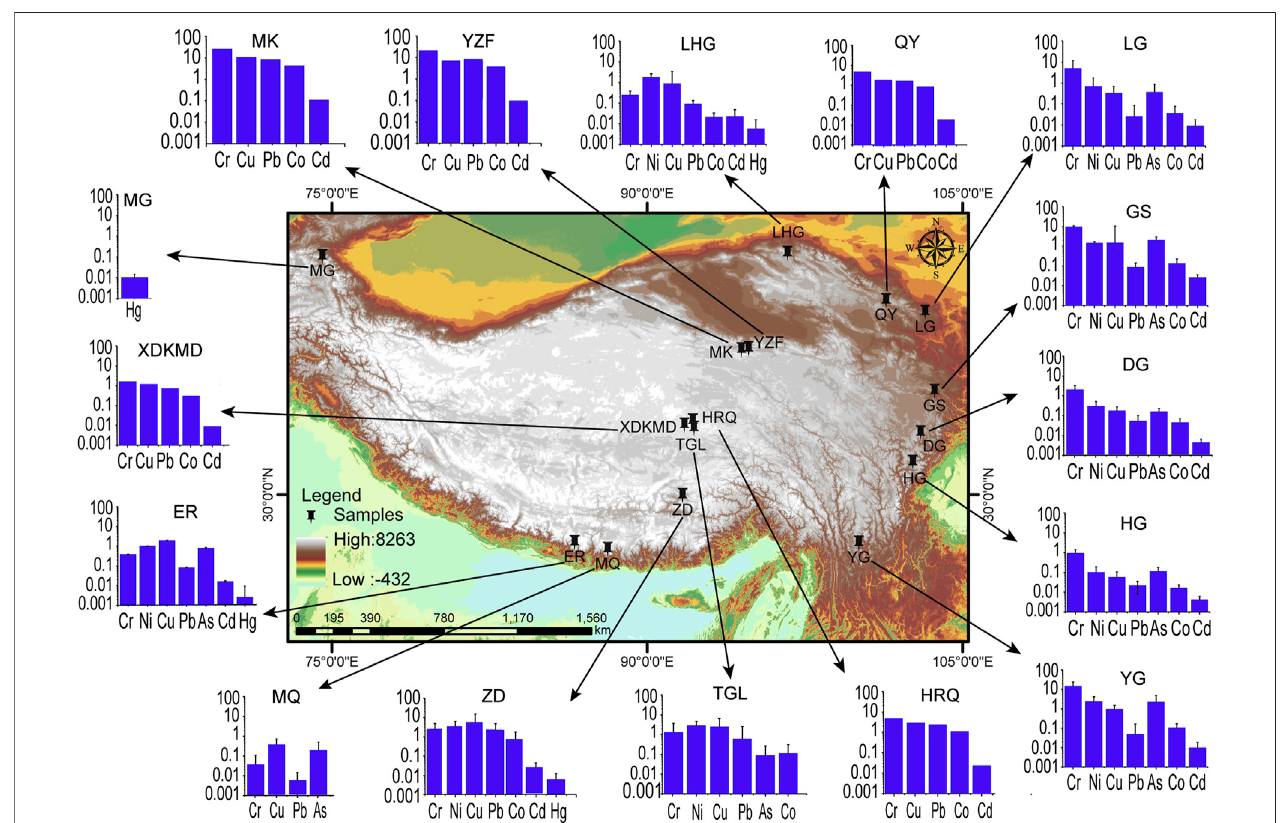
FIGURE 4 | Spatial distribution of snow samples and HMs concentrations ( μ g L − 1 ) around the TP (Kang et al., 2007; Lee et al., 2008; Liu et al., 2011; Huang et al., 2014;Dongetal.,2015;LiY.etal.,2020;Jiaoetal.,2021).Notes:1)LG,LenglonglingGlacier;DG,DaguGlacier;HG,HailuogouGlacier;GS,GannanSnow;YG,Yulong Snow-mountain Glacier; QY, Qiyi Glacier; MK, Meikuang Glacier; YZF, Yuzhufeng Glacier; HRQ, Hariqin Glacier; XDKMD, Xiaodongkemadi Glacier; LHG, Laohugou Glacier;TGL,TanggulaGlacier;ZD,ZhadangGlacier;ER,EastRongbukGlacier;MQ,Mt.Qomolangma.2)Errorbarsareaddedifthereisastandarddeviation,and no error bars are added if there is no standard